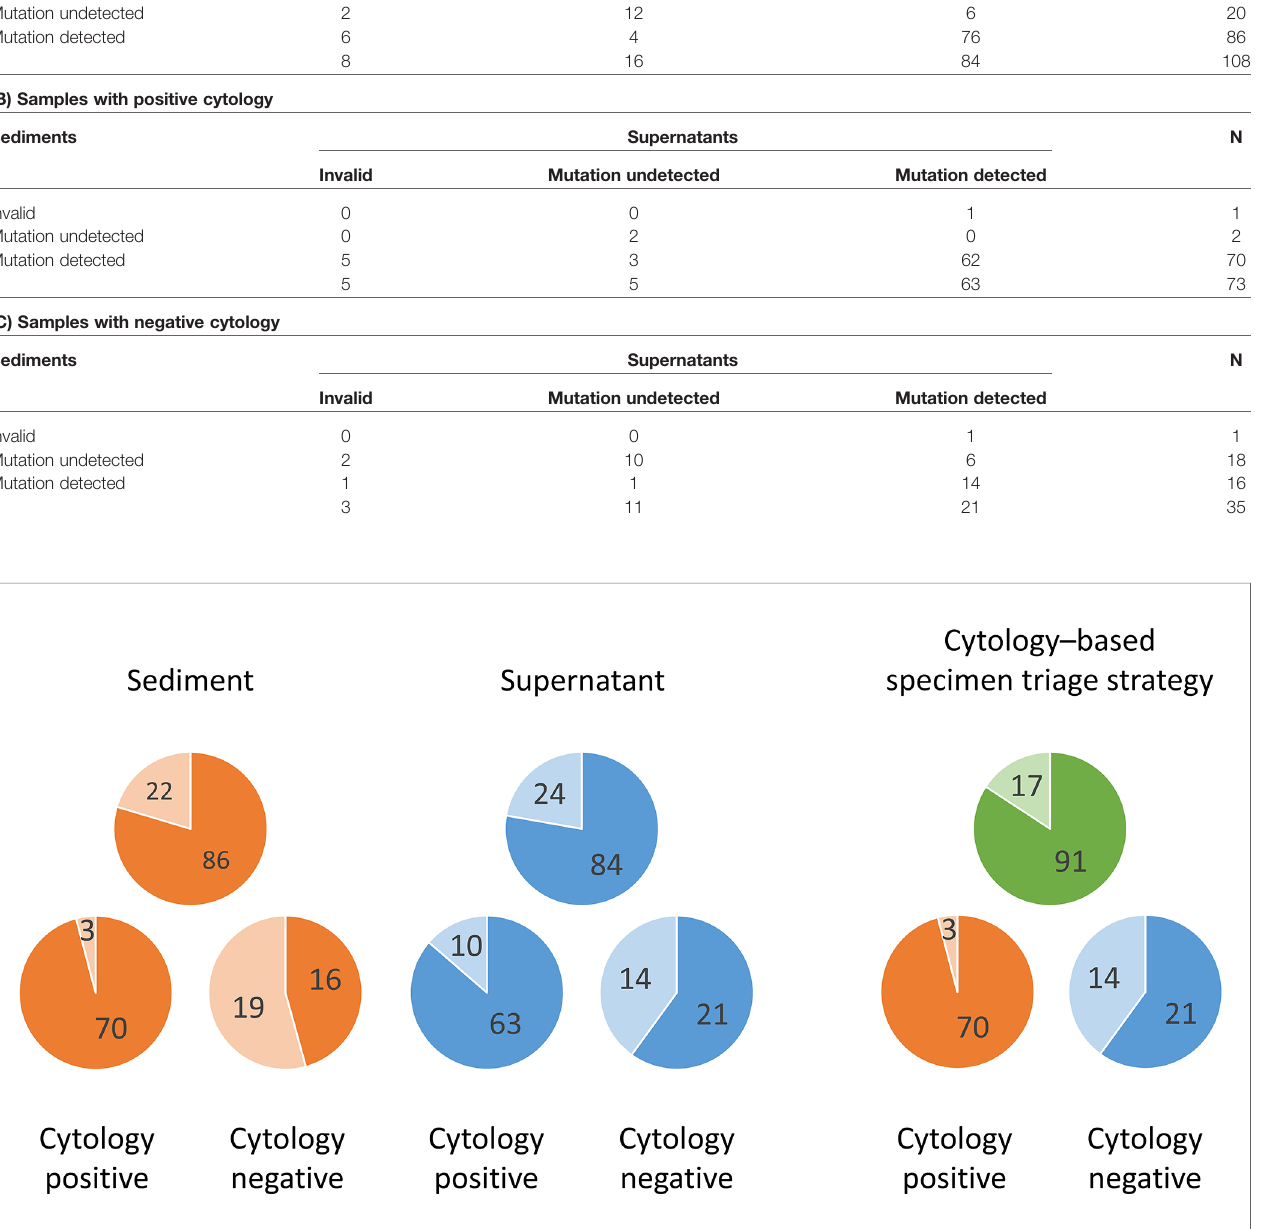
FIGURE 2 | Differences of EGFR mutation detection rates in effusion sediments and supernatants by cytology examination status (positive, n = 73; negative, n = 35) and the advantage of the proposed cytology – based specimen triage strategy. Darker color, mutation detected; lighter color, mutation